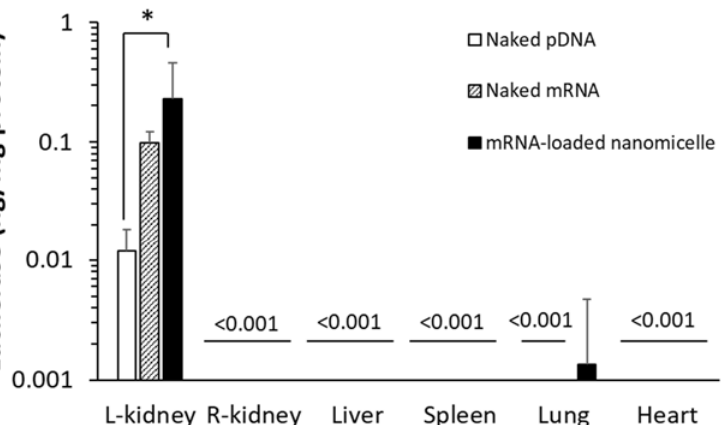
Figure 1. Quantitative measurements of luciferase expression by the extracted protein from each organ. Mice were injected with messenger RNA (mRNA) or plasmid DNA (pDNA) encoding Luciferase to the left kidney by renal pelvis injection. Luciferase expression levels were determined 6 h after administration. Data are represented as mean + SD ( n = 4–6). * p < 0.05 (Tukey’s test).